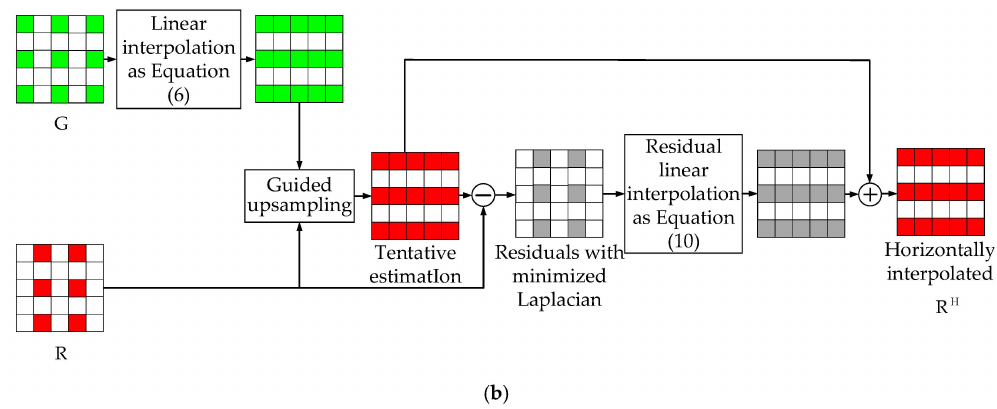
Figure 4. The horizontal R pixel value interpolation: ( a ) Adams and Hamilton’s interpolation equation [15]; ( b ) MLRI